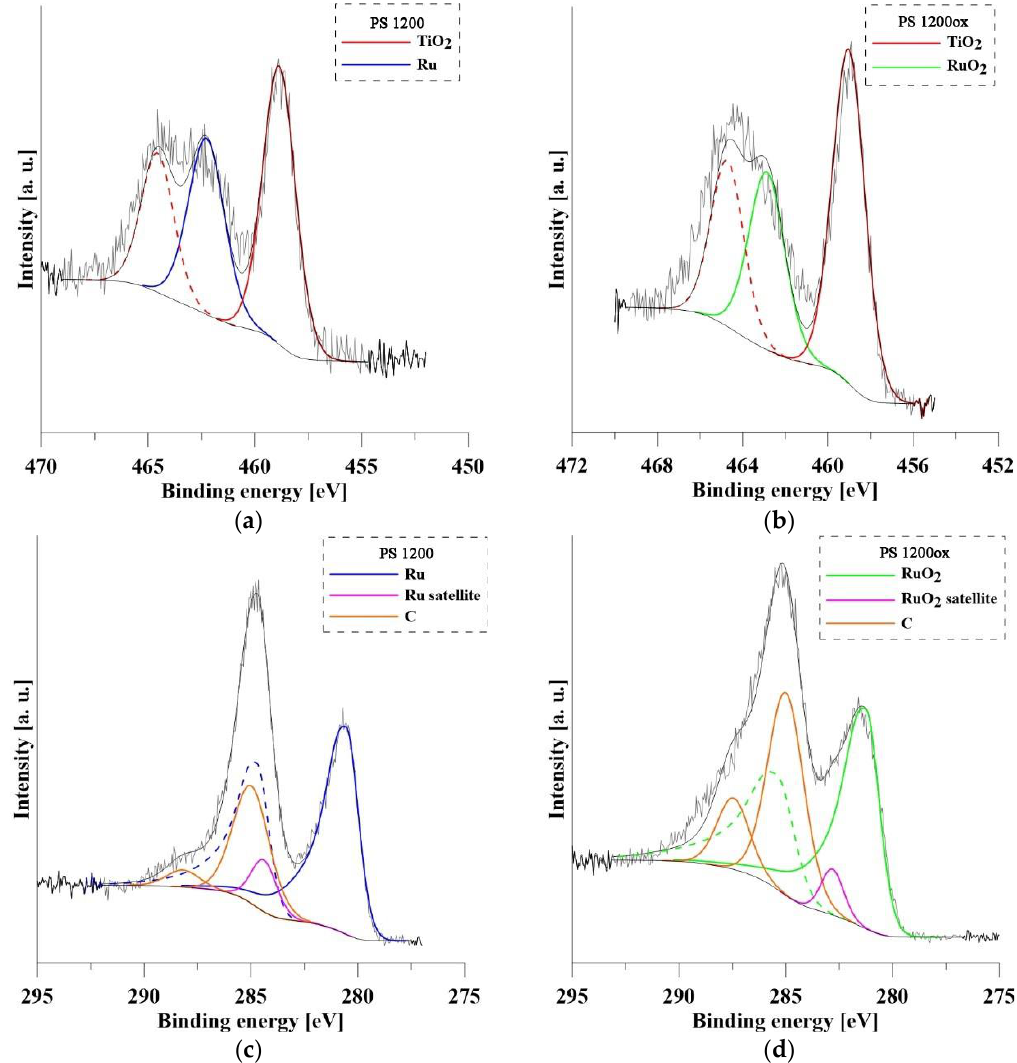
Figure 4. XPS spectra of Ti and Ru (PS 1200 and PS 1200ox): ( a ) Ru 3d and C 1s peaks — PS1200; ( b ) Ru 3d and C 1s peaks — PS1200ox; ( c ) Ru 3p and Ti 2p peaks — PS1200; ( d ) Ru 3p and Ti 2p peaks — PS1200. peaks—PS1200ox; ( c ) Ru 3p and Ti 2p peaks—PS1200; ( d ) Ru 3p and Ti 2p